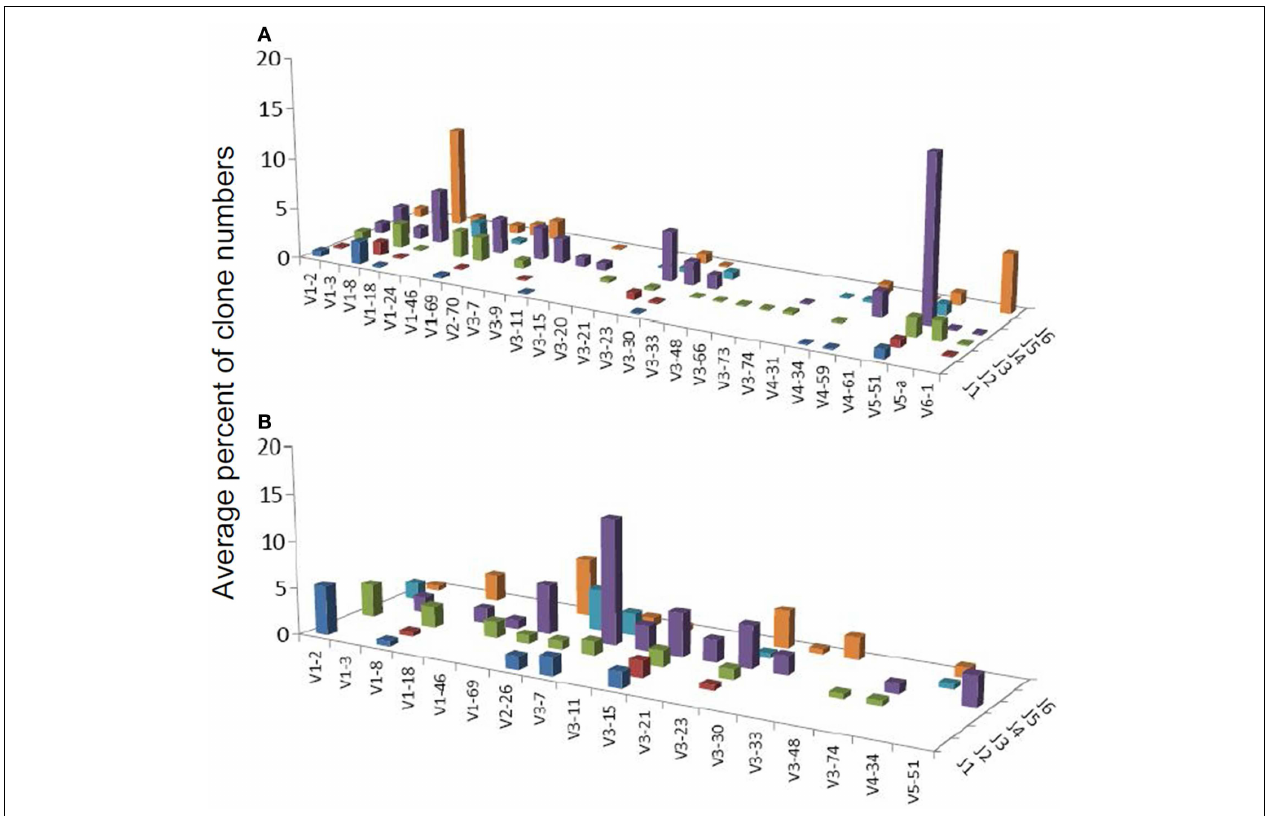
FIGURE 3 |Average percentages of clones in eachVH–JH combination, in (A) DLBCL and (B) MALT-L samples